Question: In a single sentence, describe what this figure presents.
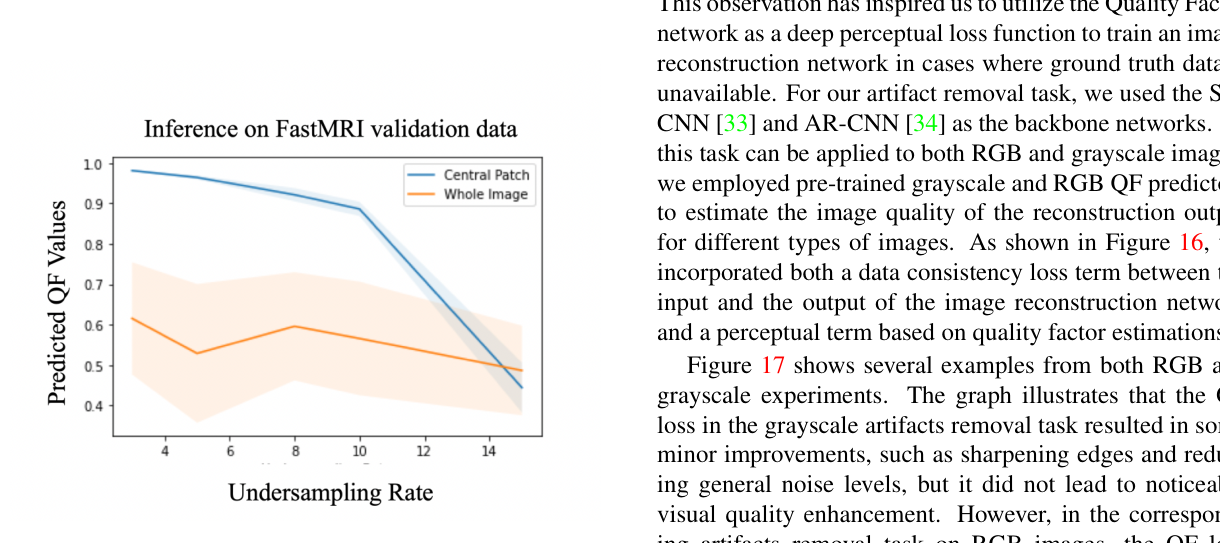
Answer: Correlation curves between the under-sampling rate and the QF prediction from the pre-trained network.